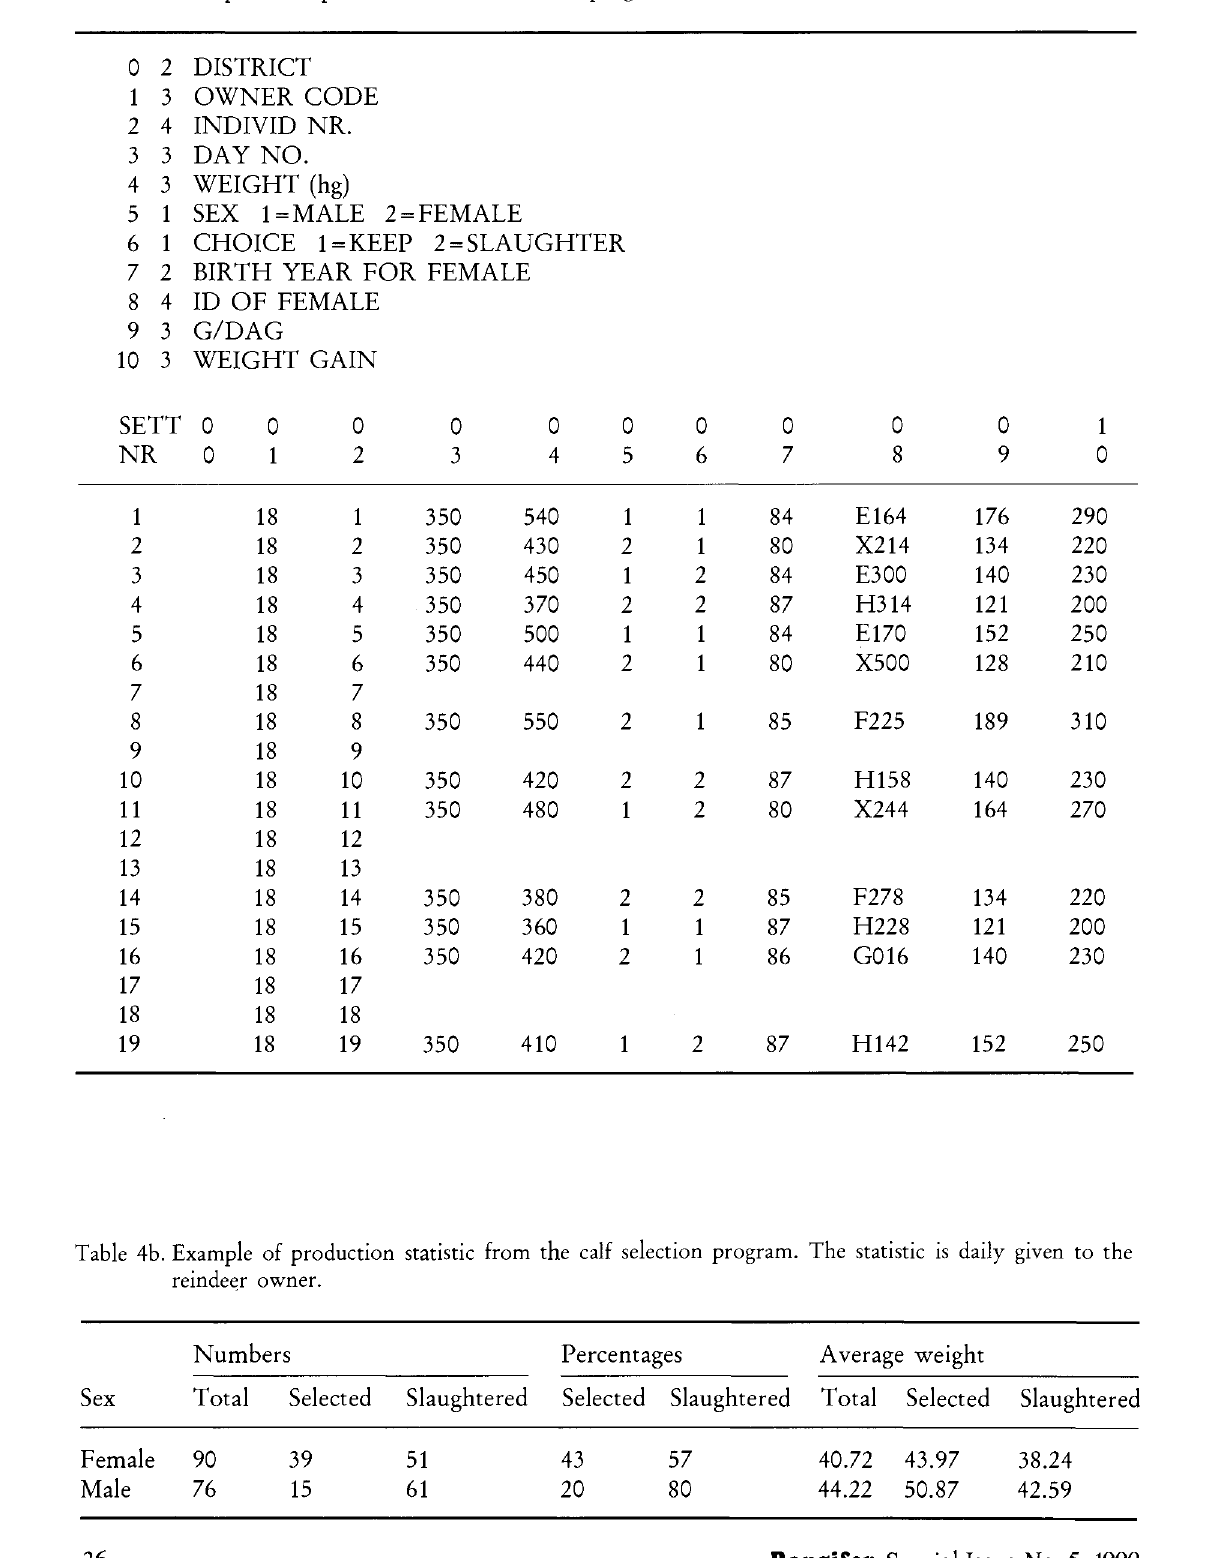
Table 4b. Example of production statistic from the calf selection program. The statistic is daily given to the reindeer